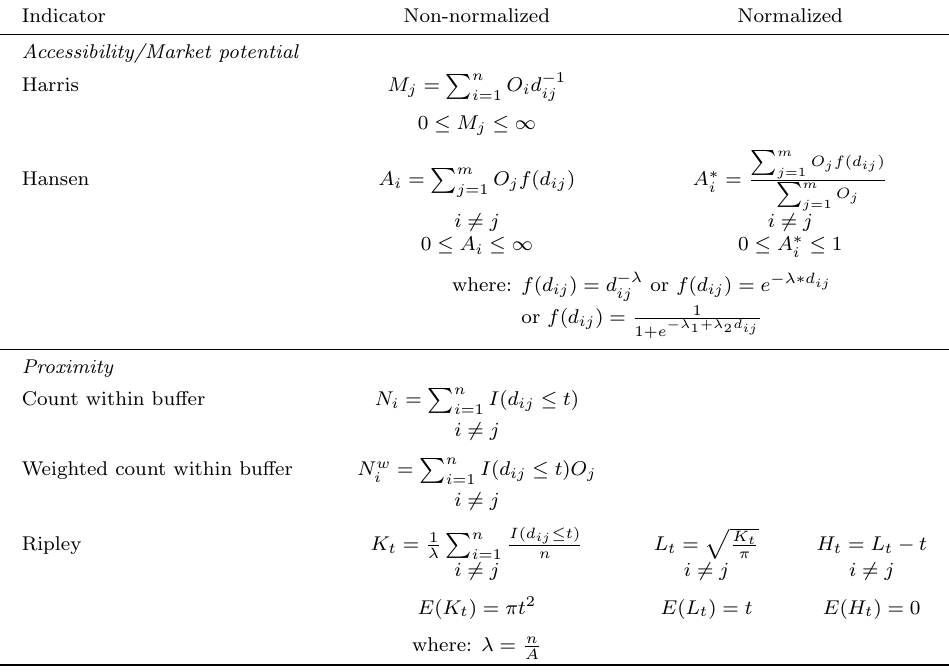
Table 10: Accessibility and proximity indicators using point-level data Indicator Non-normalized Normalized Accessibility/Market